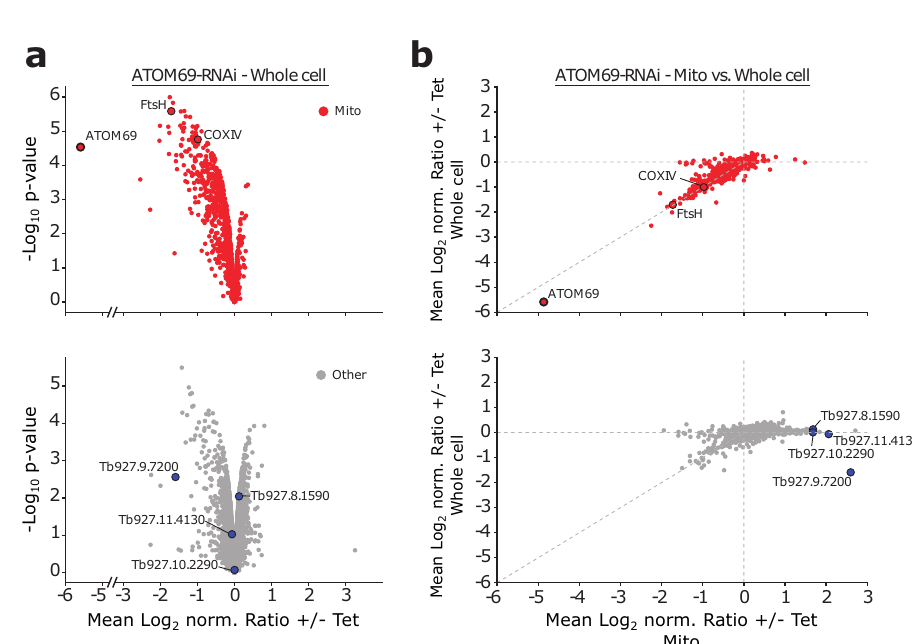
Fig. 1 Mitochondrial proteome changes after ablation of ATOM complex subunits. a General work fl ow of the quantitative proteomic analysis. The box on the left indicates a schematic model of the atypical translocase of the outer membrane (ATOM) complex with its seven subunits. Receptor subunits and the protein-conducting pore are indicated. ATOM69 is highlighted in orange. Using the stable isotope labelling by amino acids in cell culture (SILAC) method, six inducible RNAi cell lines and a conditional knock out cell line (ATOM11) were differentially labelled with stable-isotope coded heavy arginine (Arg10) and lysine (Lys8) or their light counterparts (Arg0/Lys0). Subsequently, induced ( + Tet) and uninduced ( − Tet) cells were mixed and crude mitochondrial fractions were puri fi ed by digitonin extractions ( n = 3). For the ATOM69 RNAi cell line, whole cell samples were also analysed (see Fig. 2). All samples were subjected to liquid chromatography-mass spectrometry (LC-MS) followed by computational data analysis. b , c Volcano plots visualising SILAC-based quantitative MS data of crude mitochondrial extracts (Mito) for the ATOM core subunits ATOM40, ATOM19, ATOM14, ATOM12 and ATOM11 ( b ) and the ATOM receptor subunits ATOM46 and ATOM69 ( c ). Induction times for the indicated cell lines grown in SILAC medium were ATOM40 (3 d), ATOM19 (3.17 d), ATOM14 (3 d), ATOM12 (3 d), ATOM11 (4 d), ATOM46 (6 d) and ATOM69 (5 d).